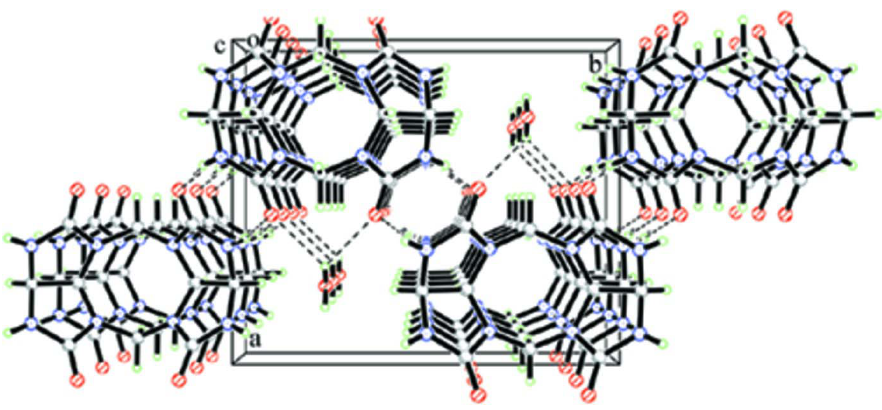
Figure 2 Packing diagram of (I). Hydrogen bonds are shown as dashed lines. 1,3,5,7,9,11,13,15-Octaazapentacyclo[9.5.1.1 3,9 .0 6,18 .0 14,17 ]octadecane- 4,8,12,16-tetrone